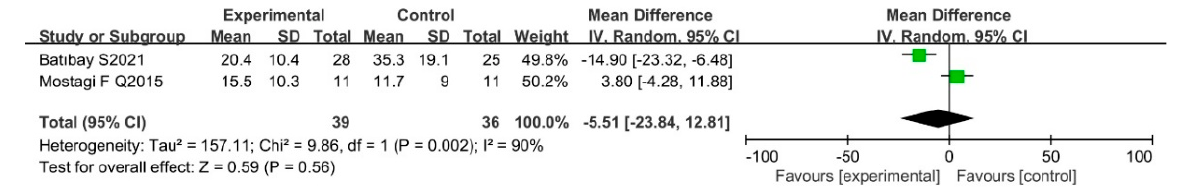
Figure 8. Meta-analysis of the effect of Pilates on QBPDS in CLBP patients [47,53].